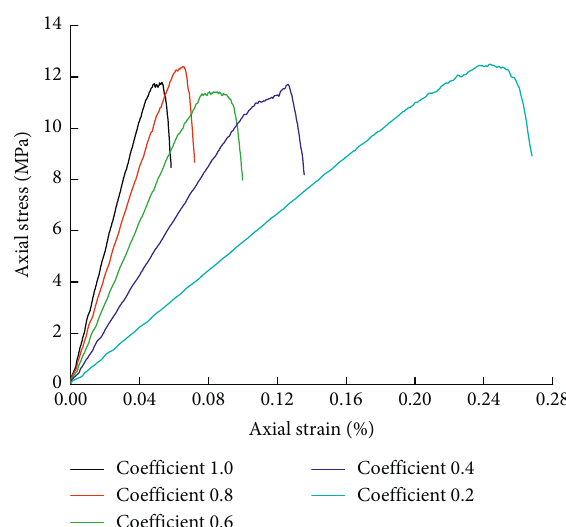
Figure 6: Axial stress-strain curves from Brazilian disc tests for the different coefficients of E ∗ .